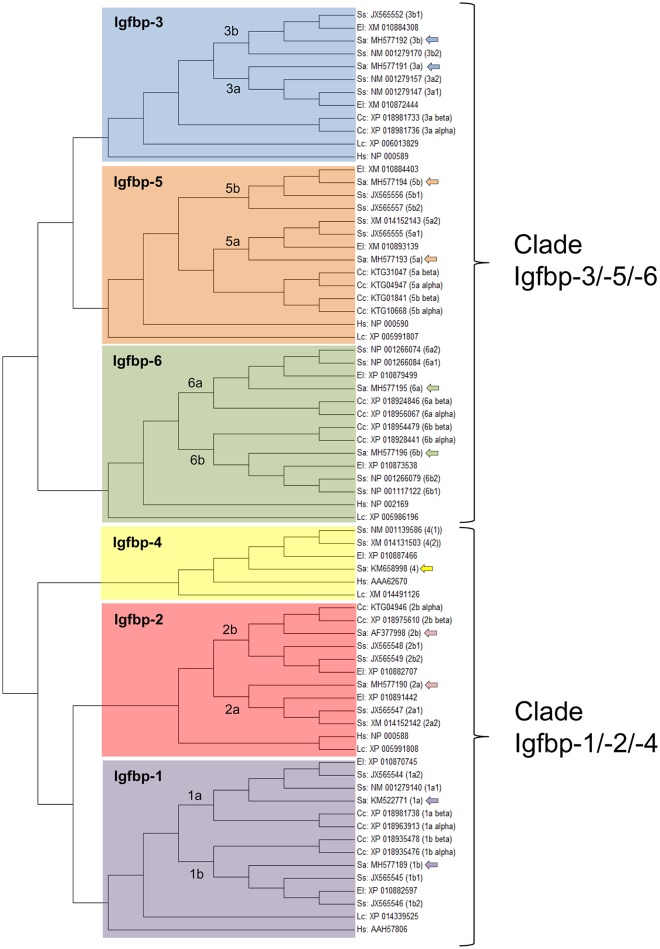
Phylogenetic analysis of the Igfbp family, evidencing the two Igfbp modern vertebrate clades and the expansion of the family in teleosts. The unrooted tree was constructed by means of Mega 6.0 using the maximum likelihood method, with the amino acid alignment of 72 Igfbp sequences from Human, Homo sapiens (Hs); Comoran coelacanth, Latimeria chalumnae (Lc); northern pike, Esox lucius (El); carp, Cyprinus carpio (Cc); Atlantic salmon, Salmo salar (Ss); and gilthead sea bream, Sparus aurata (Sa). GenBank accession numbers are given for all sequences. Duplication events in teleosts are shown. The 11 gilthead sea bream sequences, including igfbp-4 and paralog pairs of igfbp-1, -2, -3, -5, and -6 are marked with arrows.